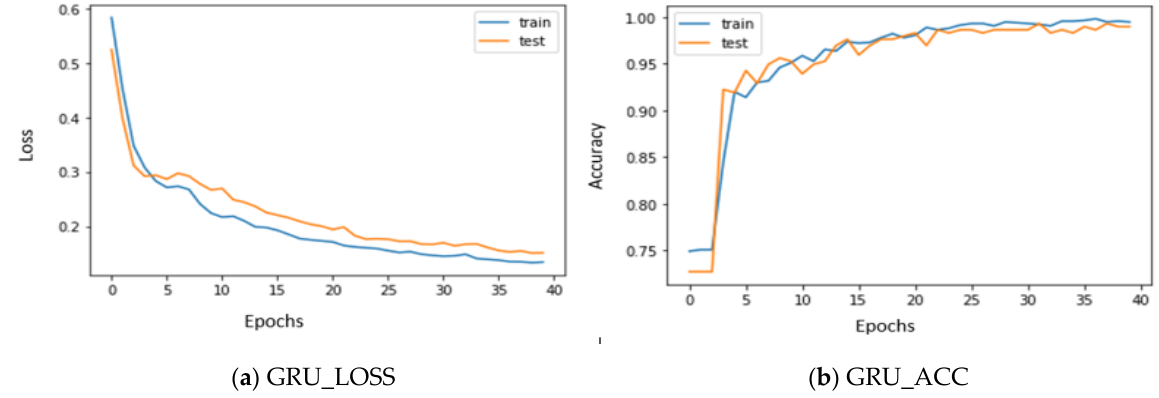
Figure 5. The loss and the accuracy curve of GRU_model .